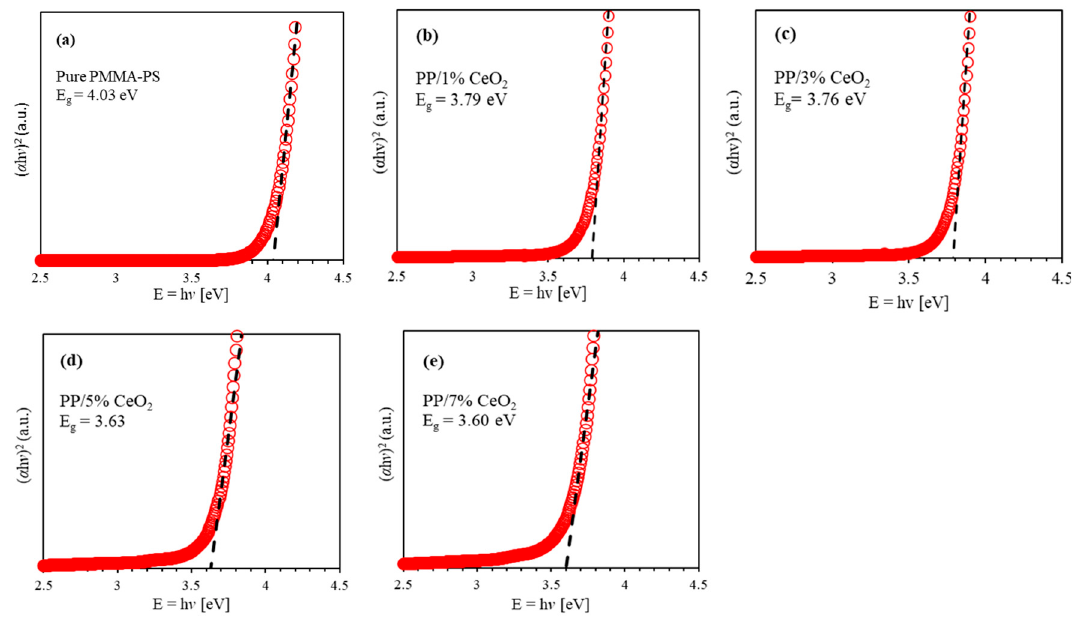
Figure 5. The Tauc plot for energy band gap E g of (PMMA-PS)/CeO 2 nanocomposite thin films containing various CeO 2 NPs concentrations. ( a ) Band gap of Pure PMMA-PS; ( b ) Band gap of PMMA-PS/1% CeO 2 ; ( c ) Band gap of PMMA-PS/3% CeO 2 ; ( d ) Band gap of PMMA-PS/5% CeO 2 ; ( e ) Band gap of PMMA-PS/5% CeO 2